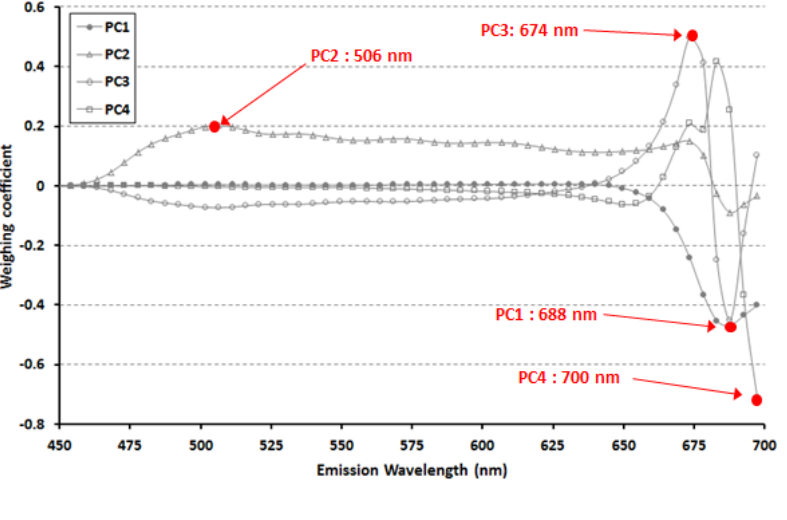
Figure 6. Spectral weighting coefficients for principal components.